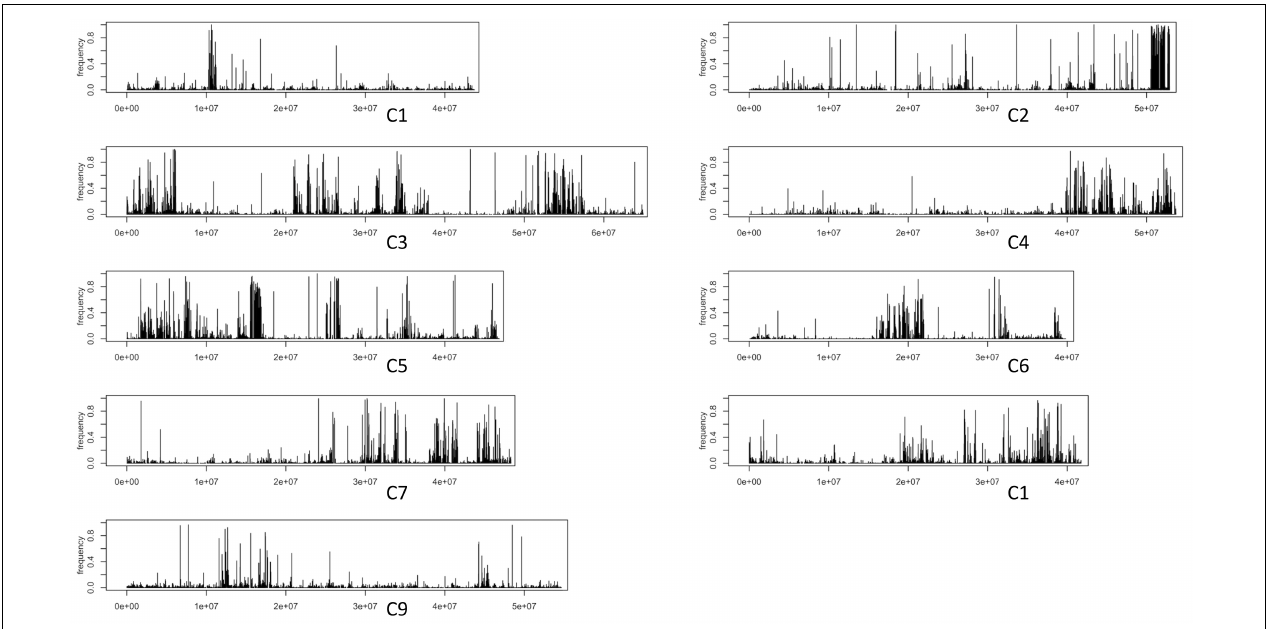
FIGURE 2 | Signals for potential introgression traces from Brassica villosa Introgression from k-mer analyses. In the 1086 F 1 hybrid, each black horizontal line in the plot marks a contig of a draft-assembled high-glucoraphanin genome. The height of each line is according to the fraction of k-mers in a contig that is unique to B. villosa